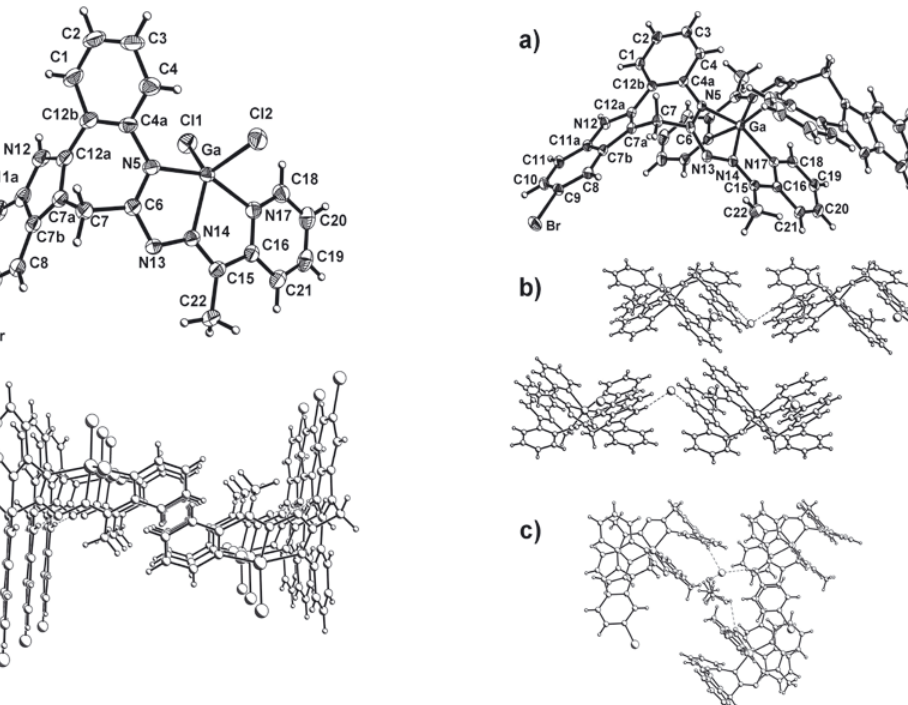
Figure 3. a) ORTEP plot of molecule of 5 with atom labeling scheme; thermal ellipsoids are drawn at 50% proba- Figure 4. a) ORTEP plot of molecule of 6 with atom labeling scheme; bility level. Selected bond distances (Å) and angles (°): Ga-N5 2.0050(23), Ga-N14 2.0190(21), Ga-N17 thermal ellipsoids are drawn at 50% probability level; b) Chains of 6 stabilized by hydrogen bonds; view approxi- mately along [0 1 0]; c) Involvement of the disordered ethanol in hydrogen bonds with N13 or